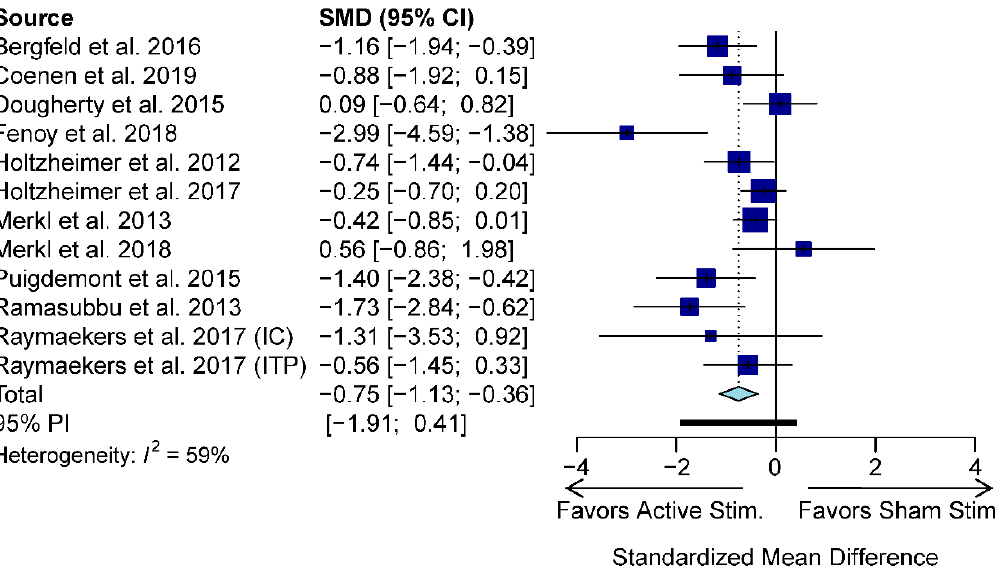
Figure 2. Meta-analysis forest plot depicting changes in HDRS / MADRS scores with active stimulation compared to sham stimulation. CI: confidence interval; IC: internal capsule; ITP: inferior thalamic peduncle; SMD: standardized mean di ff erence; PI: prediction